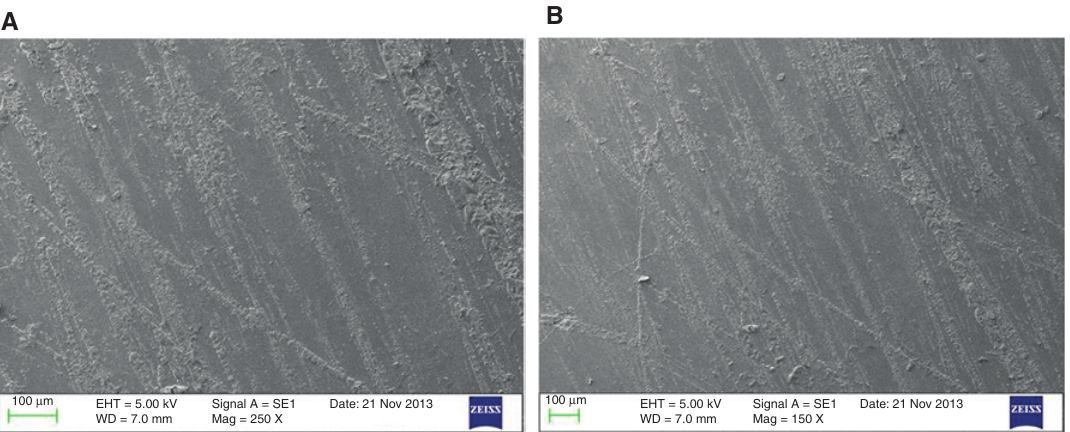
Figure 10: Abraded scanning electron microscopy (SEM) images of polyurethane (PU)-prepolymer (A) WPUDCO-1 and (B)